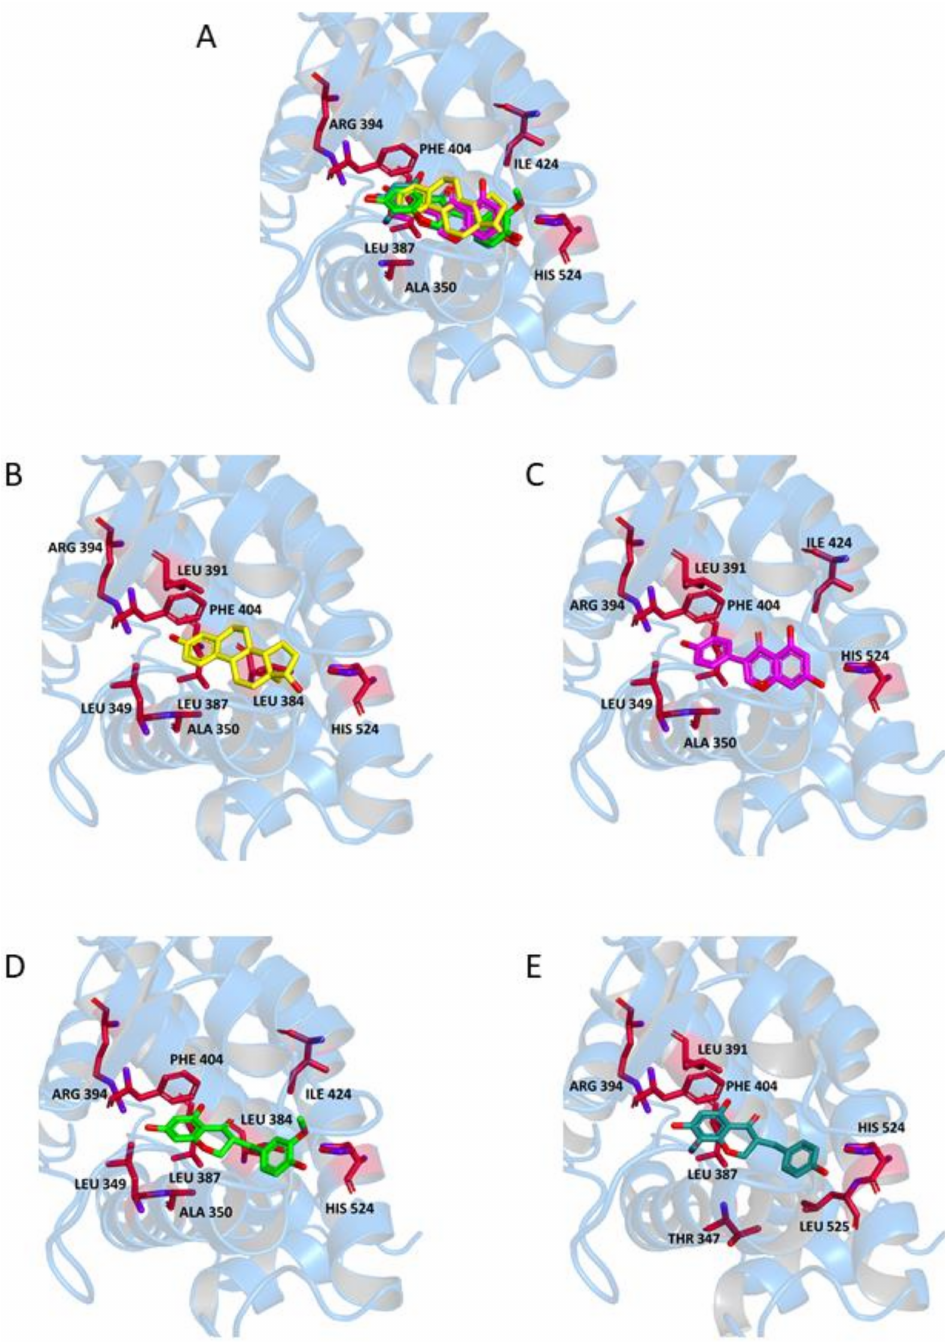
Figure 5. Ligand-binding pocket of the active site of ER α ; ribbons representing protein structural elements are also shown. ( A ) Superimposed binding modes of all the four ligands: E (yellow), G (magenta), (R)-N1 (green), and (R)-N2 (cyan); the key residues are also indicated in the specific binding mode of ( B ) E ; ( C ) G ; ( D ) (R)-N1 ; and ( E ) (R)-N2